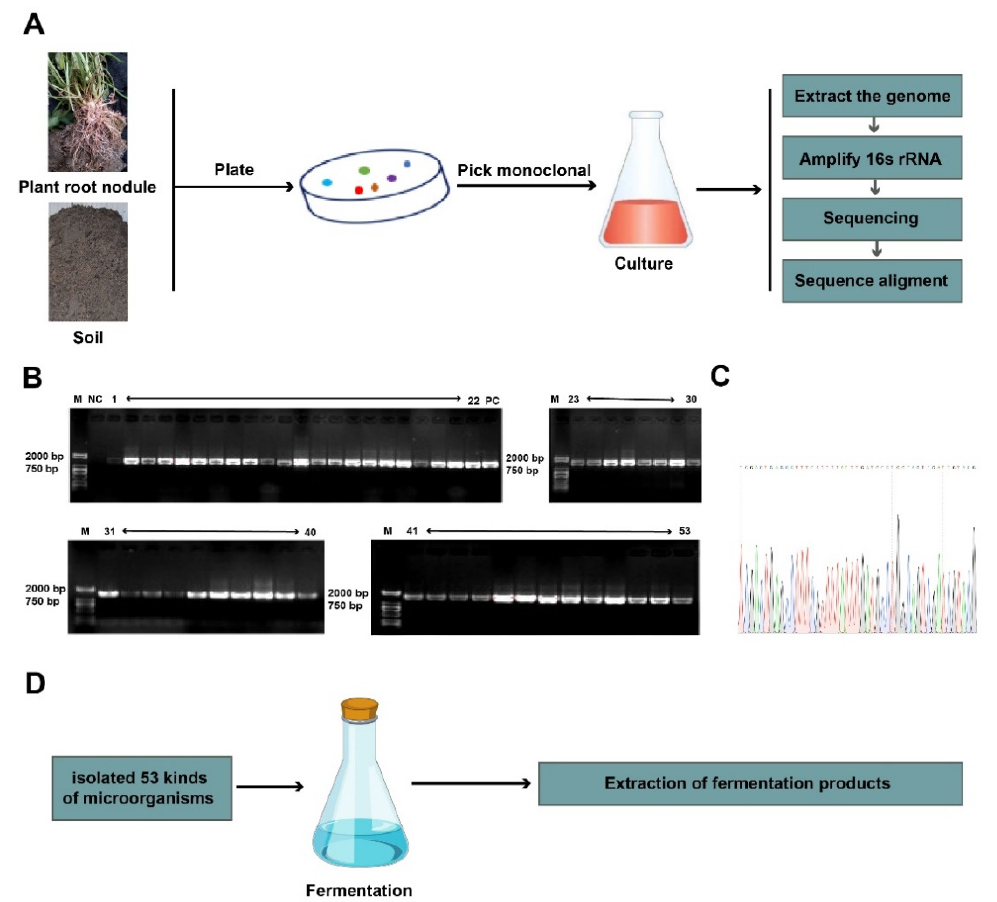
Figure 1. Isolation and identification of 53 microbial fermentation products. ( A ) Schematic of isolation and identification of a plant root nodule and soil microbes. ( B , C ) The PCR identification and sequencing of isolated microorganisms. ( D ) Schematic extraction of fermentation products (products 1, 2, 3, 4, 5, 6, 7, 8, 9, 10, 11, 12, 13, 14, 15, 16, 17, 18, 19, 20, 21, 22, 23, 24, 25, 26, 27, 28, 29, 30, 31, 32, 33, 34, 35, 36, 37, 38, 39, 40, 41, 42, 43, 44, 45, 46, 47, 48, 49, 50, 51, 52, and 53) from natural micro- organisms.